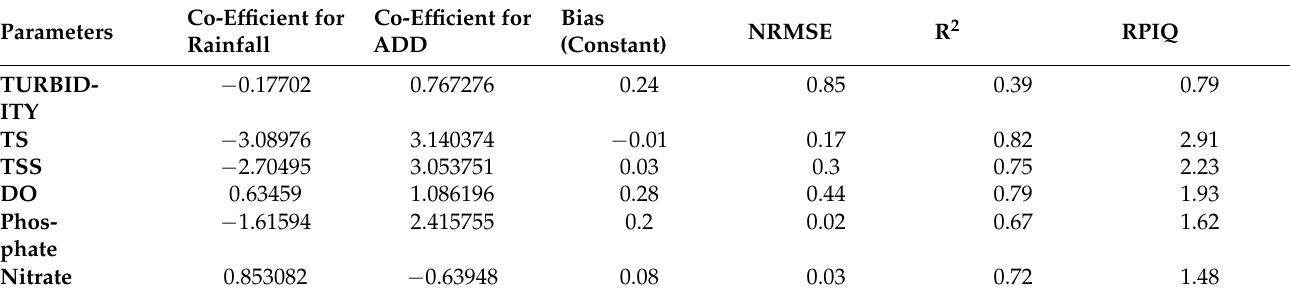
Table 4. Results of the Support Vector Regression